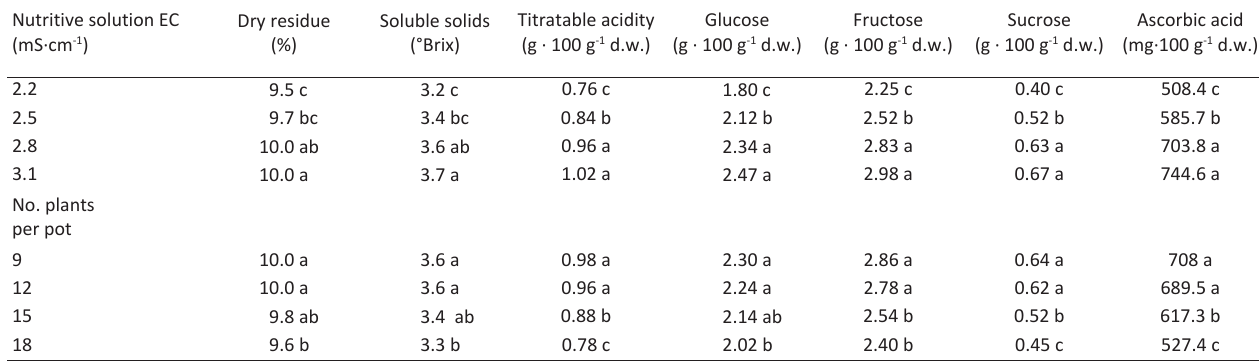
Table 5 - Basil leaves quality indicators Nutritive solution EC (mS·cm -1